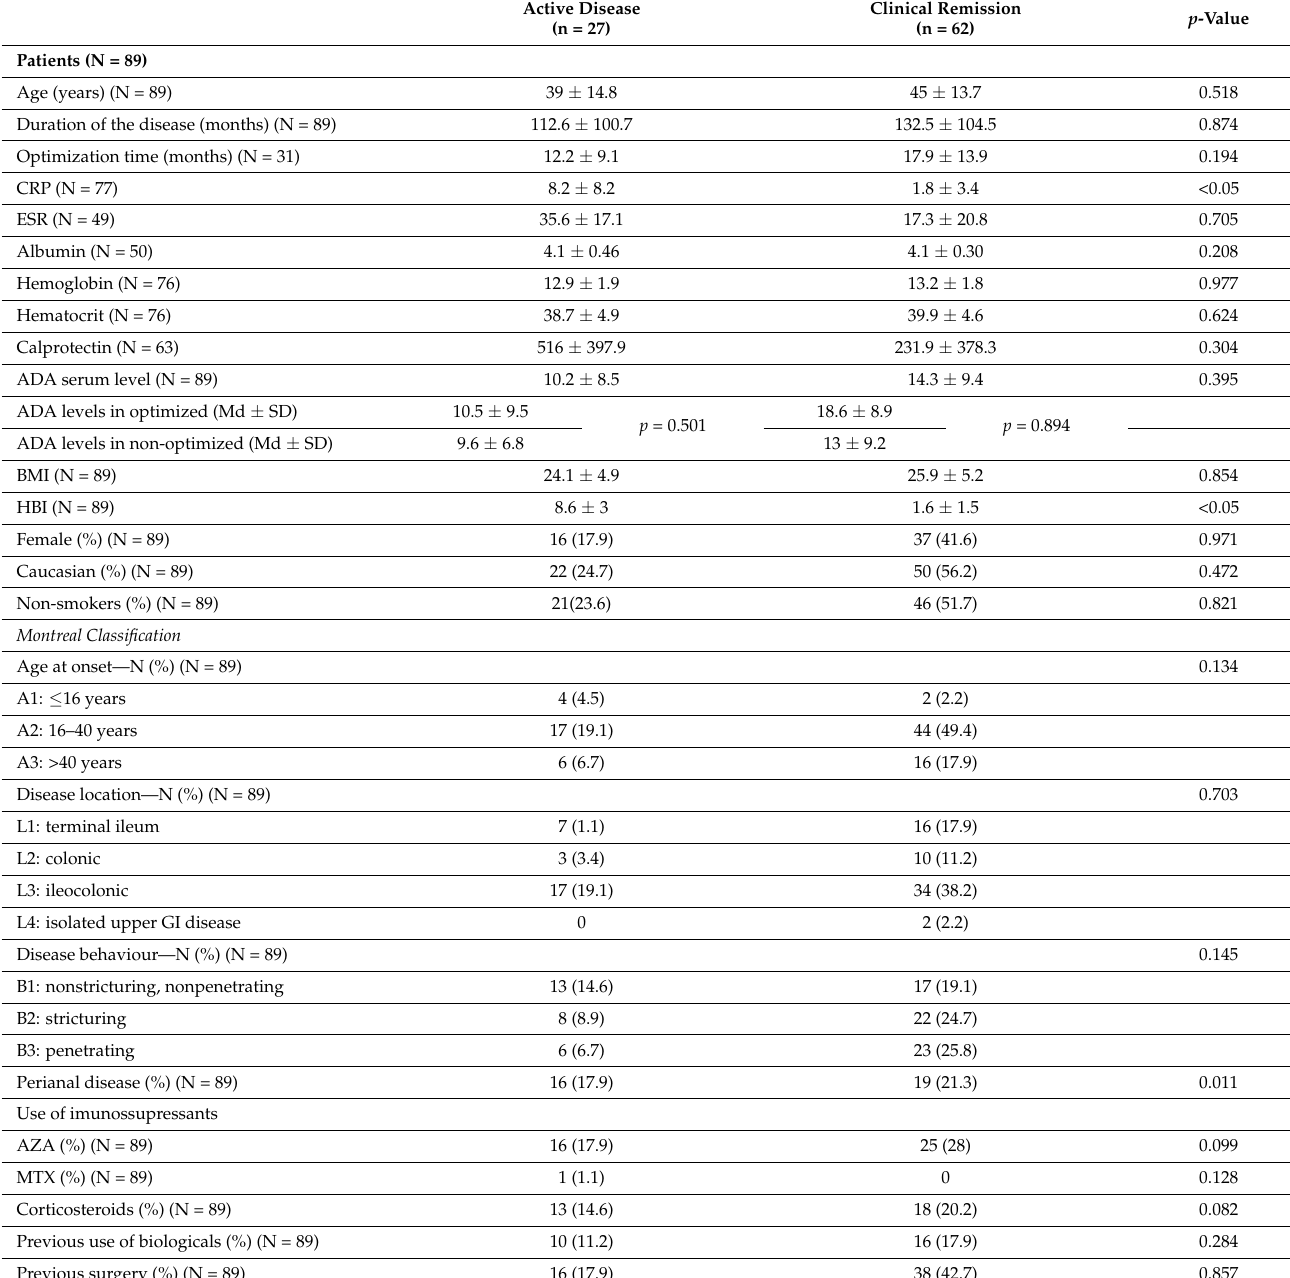
Table 1 describes in detail the baseline characteristics and demographics of patients between the 2 subgroups (according to the presence or not of clinically active CD), such as gender, BMI, smoking status, race, age, and treatment characteristics, among others. The CD phenotype was homogeneous between the groups, with the higher proportion of patients with no perianal disease, without previous biological treatment and without previous CD- related surgery. Regardless of the degree of disease activity, most of the population did not have anemia and had adequate albumin levels. As observed, three variables were significantly associated with the presence of clinically active CD: higher CRP ( p < 0.05), higher Harvey-Bradshaw index ( p < 0.05) and the presence of perianal disease ( p = 0.011). Table 1. Baseline characteristics of patient population analyzed in subgroups regarding clinical disease activity in cd. X 2 chi-square; t